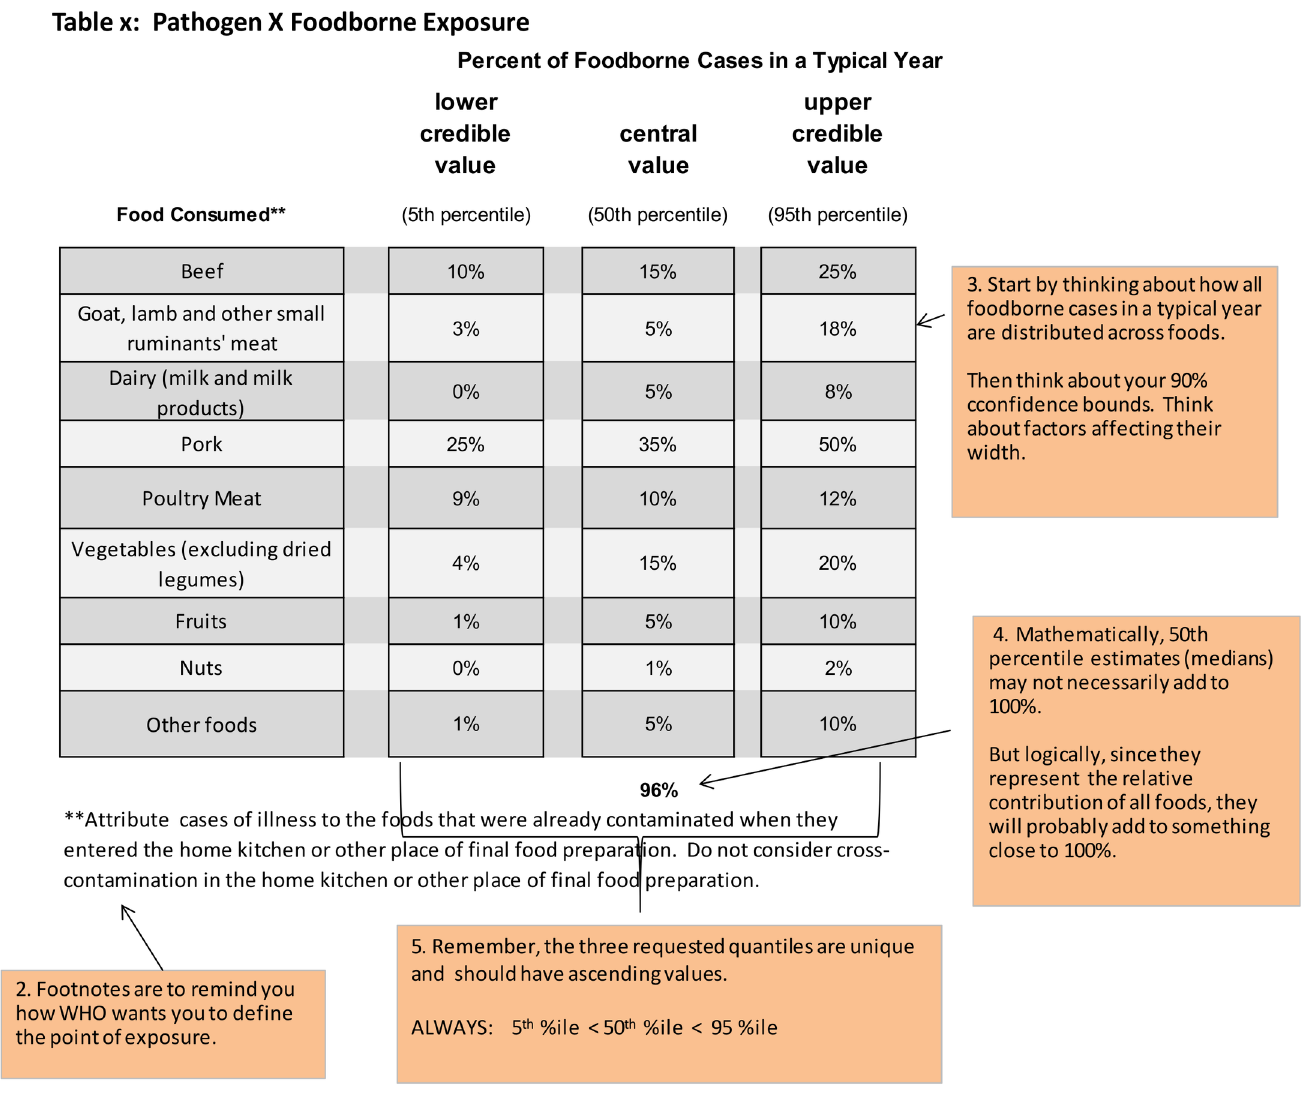
Fig 3. Example food source attribution questions provided in expert elicitation